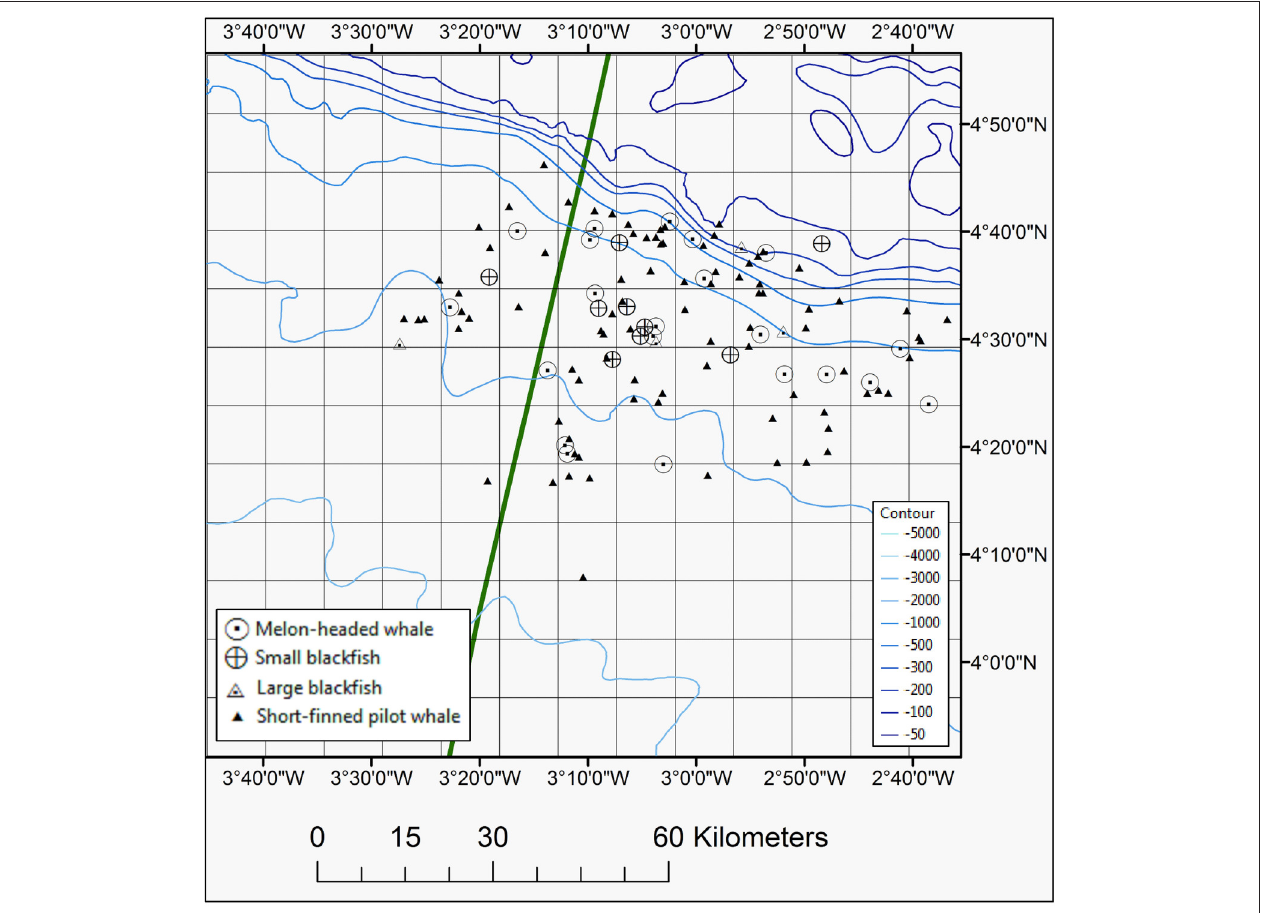
FIGURE 4 | Map showing positions of blackfish species seen during the 2013 and 2014 surveys, including short-finned pilot whale, melon-headed whale, small, and large blackfish species. The EEZ border between Côte d’Ivoire and Ghana is also shown (green thick